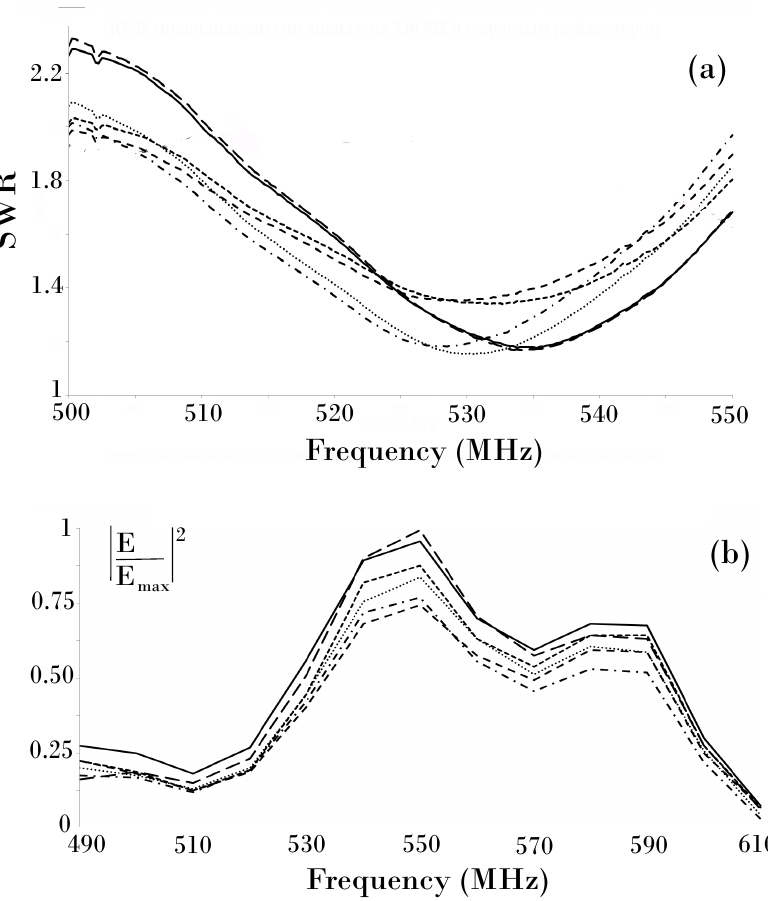
Figure 5. Dipole antenna at 540 MHz. ( a ) SWRs and ( b ) Square of the normalized field amplitude of the emitted signal as a function of frequency for six different protopypes with the following charcateristics: (i) metal radiating elements and metal reflector (solid line), (ii) metal radiating elements and carbon fabric reflector (long-dashed line), (iii) curricular winding of the carbon fiber and metal reflector (dashed line), (iv) longitudinal laying of the carbon fiber and metal reflector (dashed-dotted line), (v) curricular winding of the fiber and carbon fabric reflector (dotted line), and (vi) longitudinal laying of the fiber and carbon fabric reflector (short-dashed line). E max is the maximum value of the field